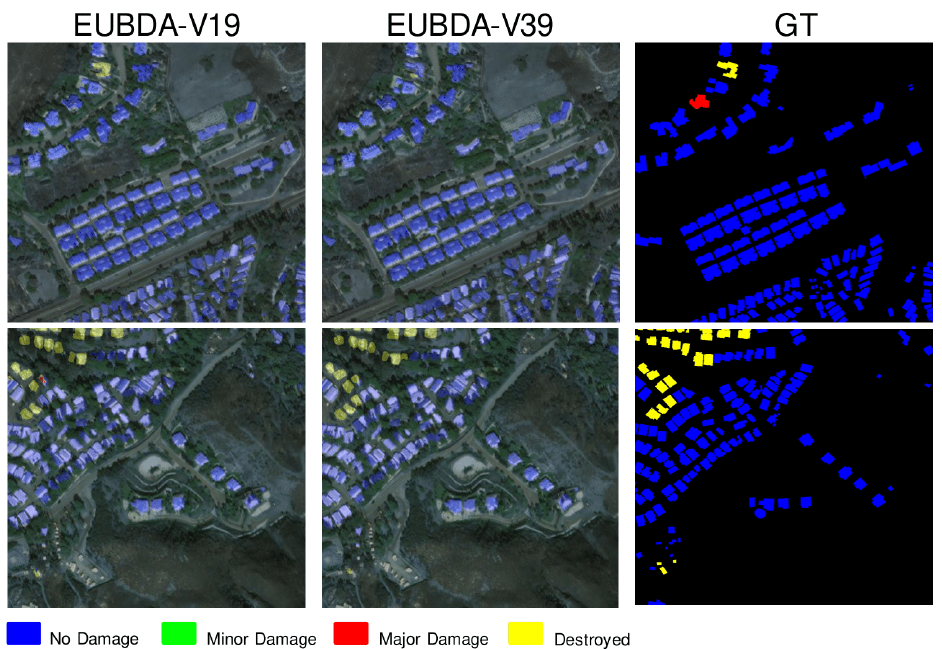
Figure 7. The qualitative examples of damage masks overlayed on original post-disaster images from the EUBDA with FA and VovNet (V19 and V39) as fusion operator and backbones. Table 3. The comparative studies of fusion operators with fixed backbone. The proposed FA achieves the best performance in overall F1 score and inference